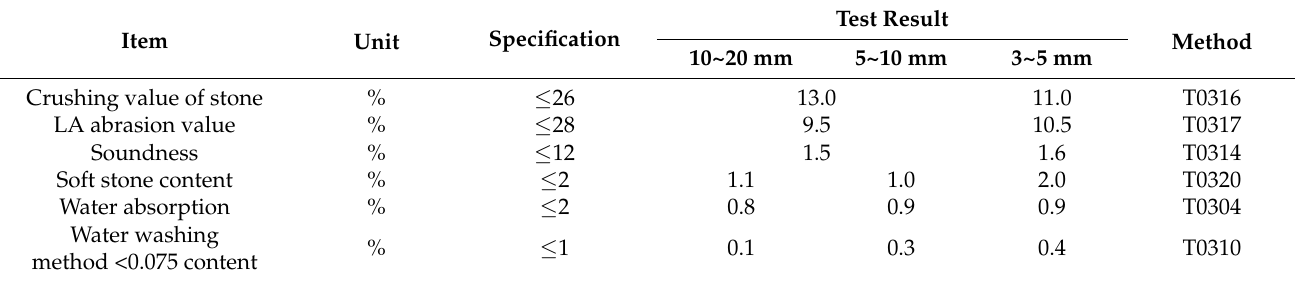
Table 3. Technical indices of coarse aggregate.